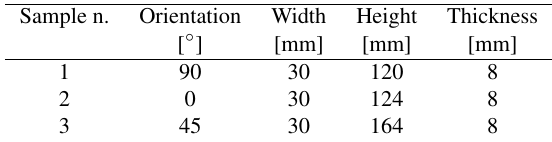
Table 1: Features of the three